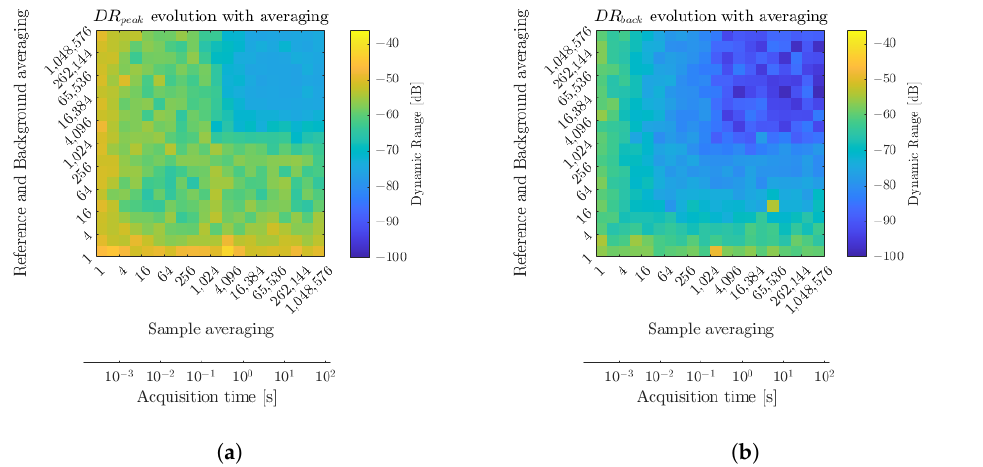
Figure 6. Dynamic range evolution of DR peak ( a ) and DR back ( b ) with sample averaging and reference and background averaging, adding a parallel between sample averaging and acquisition